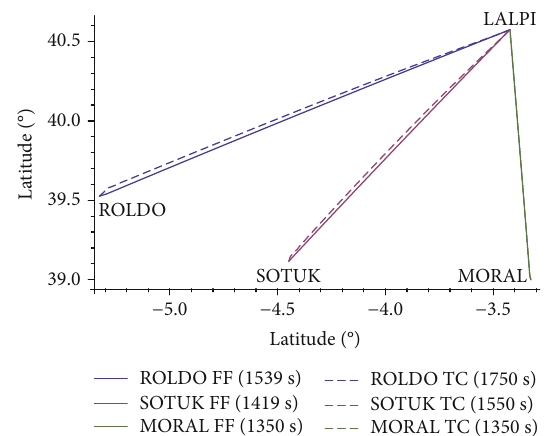
Figure 5: Experiment 1. Horizontal pro fi les with (TC, dashed lines) and without (FF, solid lines) time-based separation constraints.